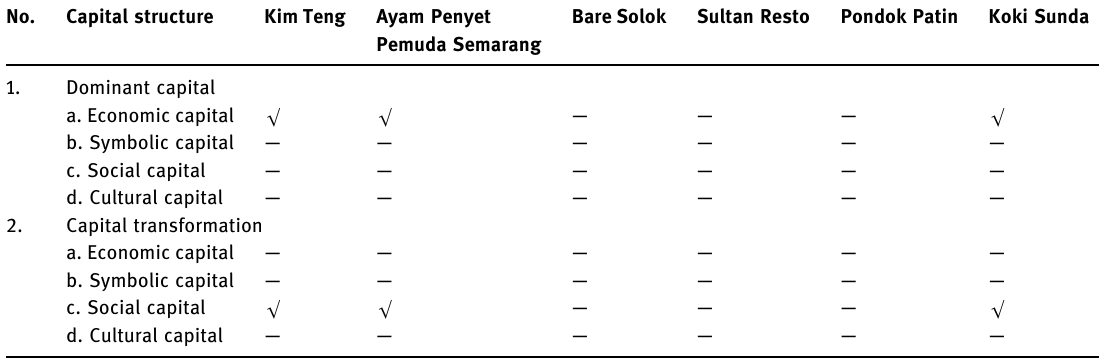
Table 1: The fi eld of community No. Capital